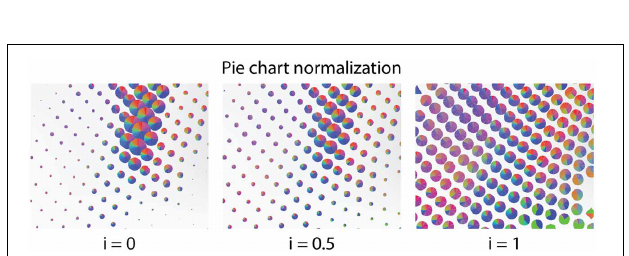
FIGURE 4 | The size of the pie charts is linearly interpolated between conveying the number of connected nodes (Left) and a constant radius